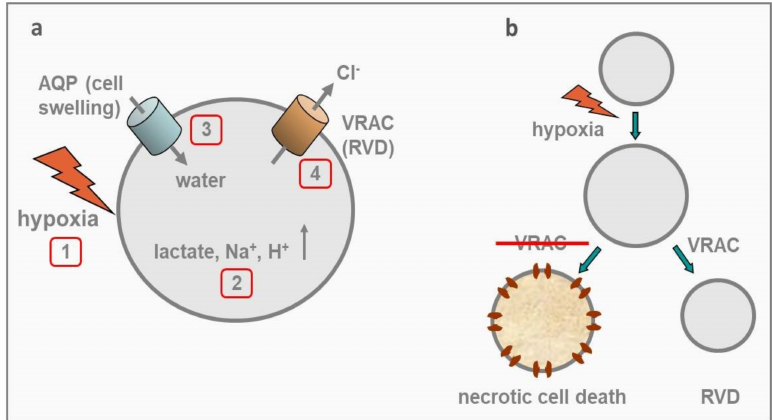
Figure 5. Hypoxia, VRAC, RVD, and GBM cell survival. ( a ) Sequence of events induced by hypoxia on a generic cell. Hypoxia (1) switches cell metabolism to anaerobic mode, with the result that